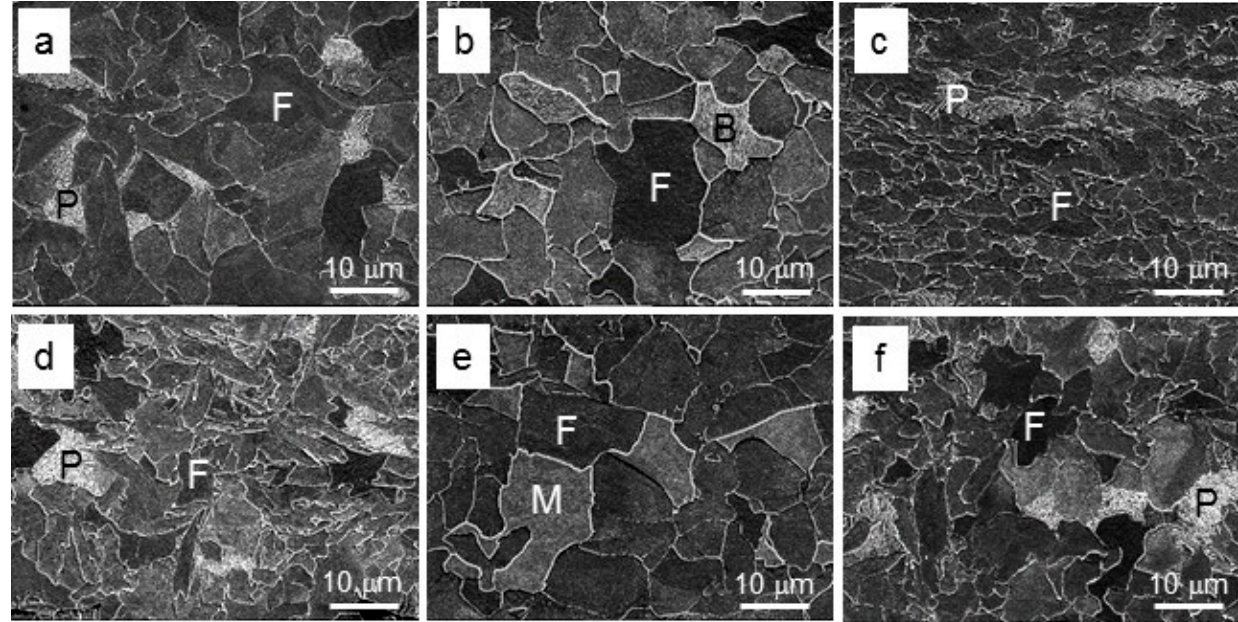
Figure 2. SEM images of microstructures showing the phase balance: ( a ) HFT/600/15, ( b ) HFT/650/15, ( c ) LFT/600/15, ( d ) HFT/600/30, ( e ) HFT/650/30, ( f ) LFT/600/30.